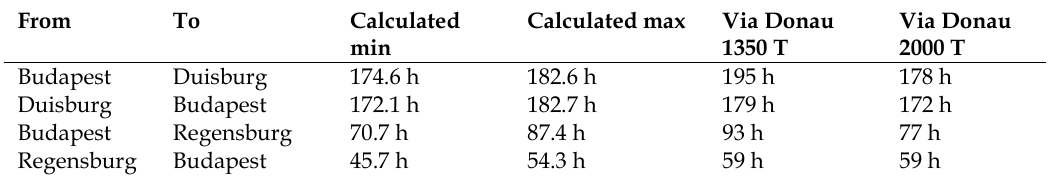
Table 3. Comparison of results for ship 2 with sailing time reported by other sources From To